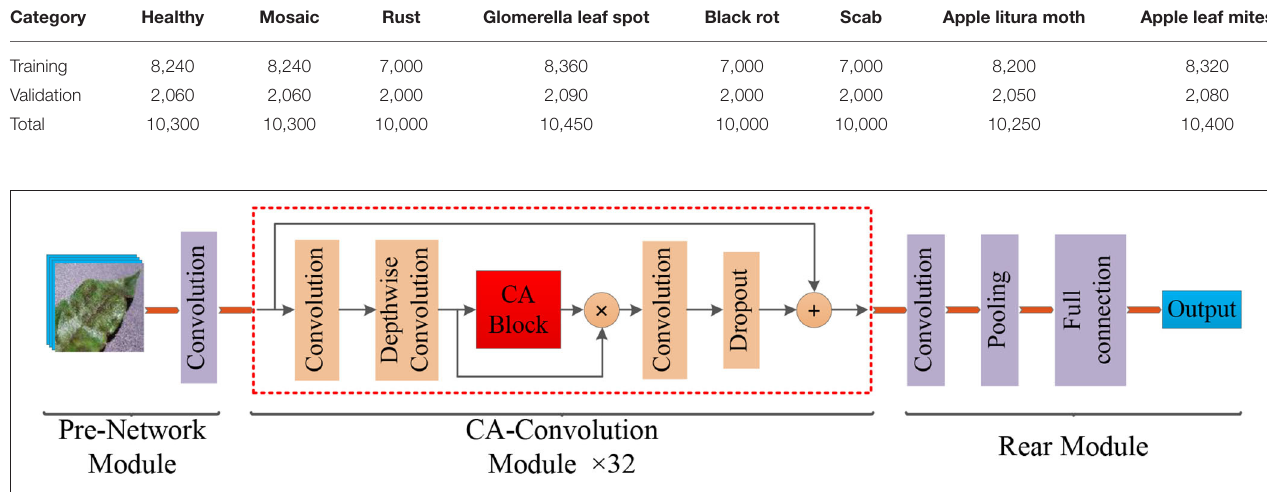
FIGURE 3 | Structure of the Coordination Attention EfficientNet (CA-ENet) for apple disease identification.